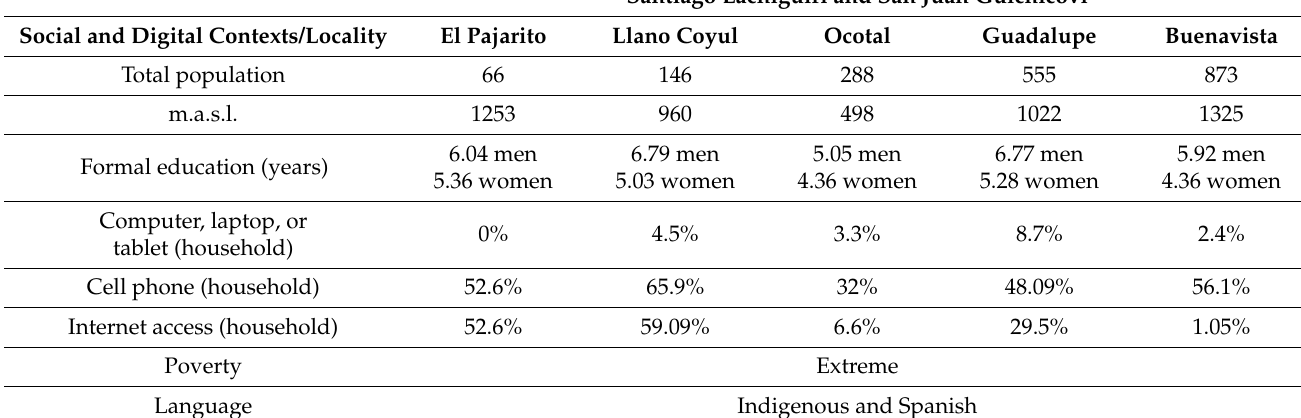
Table 2. Social and digital contexts of El Pajarito, Llano Coyul, Ocotal, Guadalupe, and Buenavista in Santiago Lachiguiri and San Juna Guichicovi in Oaxaca,